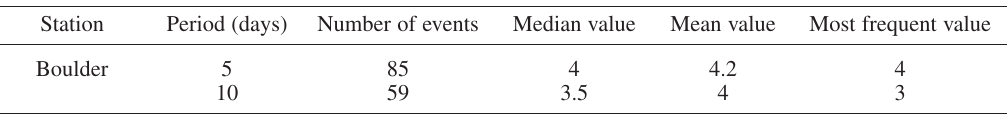
Table IV. Statistics of persistence of planetary wave type oscillations in foF 2 for stations from the Northern America and Japan based on the Morlet wavelet transform (relative values). The average values for medians and the most frequent values are presented with a step of 0.5. Station Period